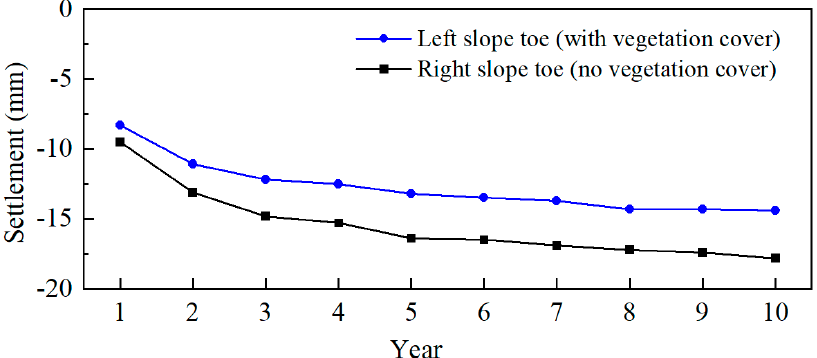
Figure 12. Subsidence of the soil at the base of the embankment slope every year in November.